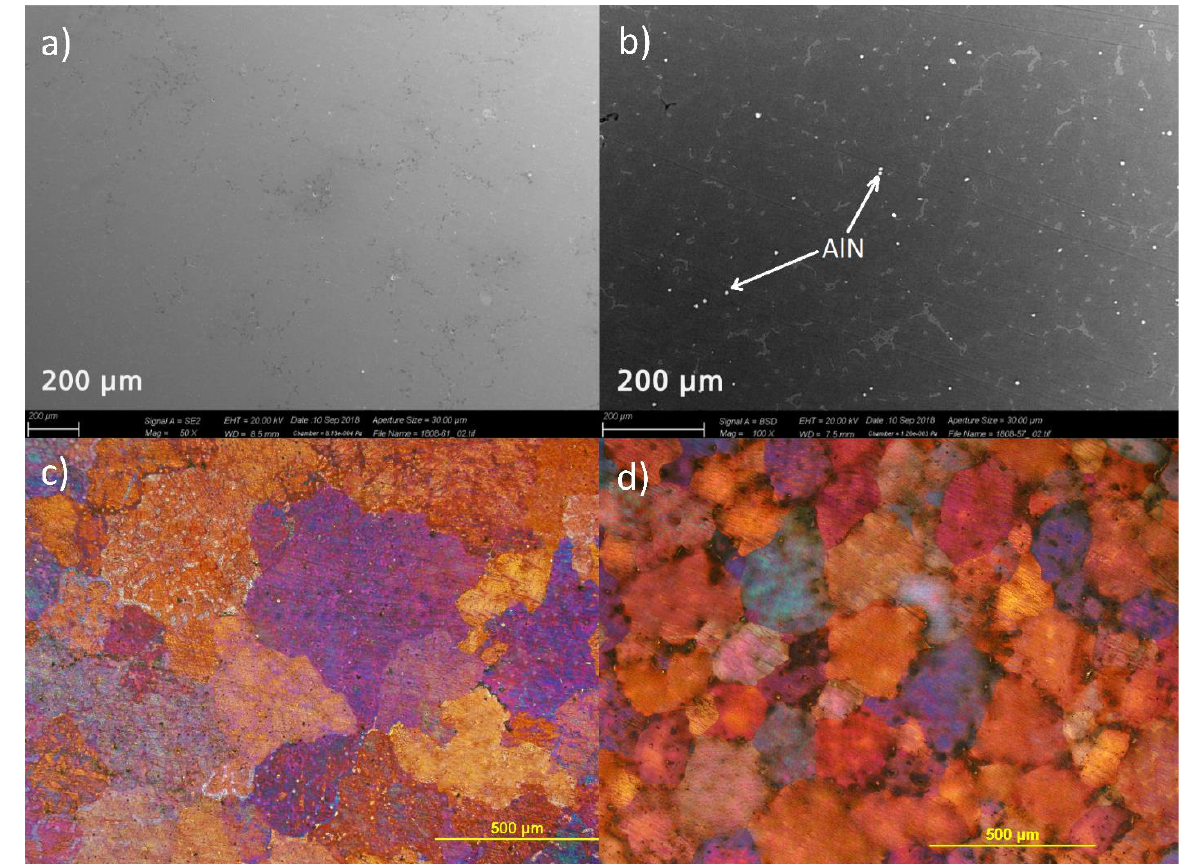
Figure 6. SEM ( a , b ) and optical ( c , d ) images of the structure of magnesium alloys AZ91 ( a , c ), AZ91-AlN ( b , d ).